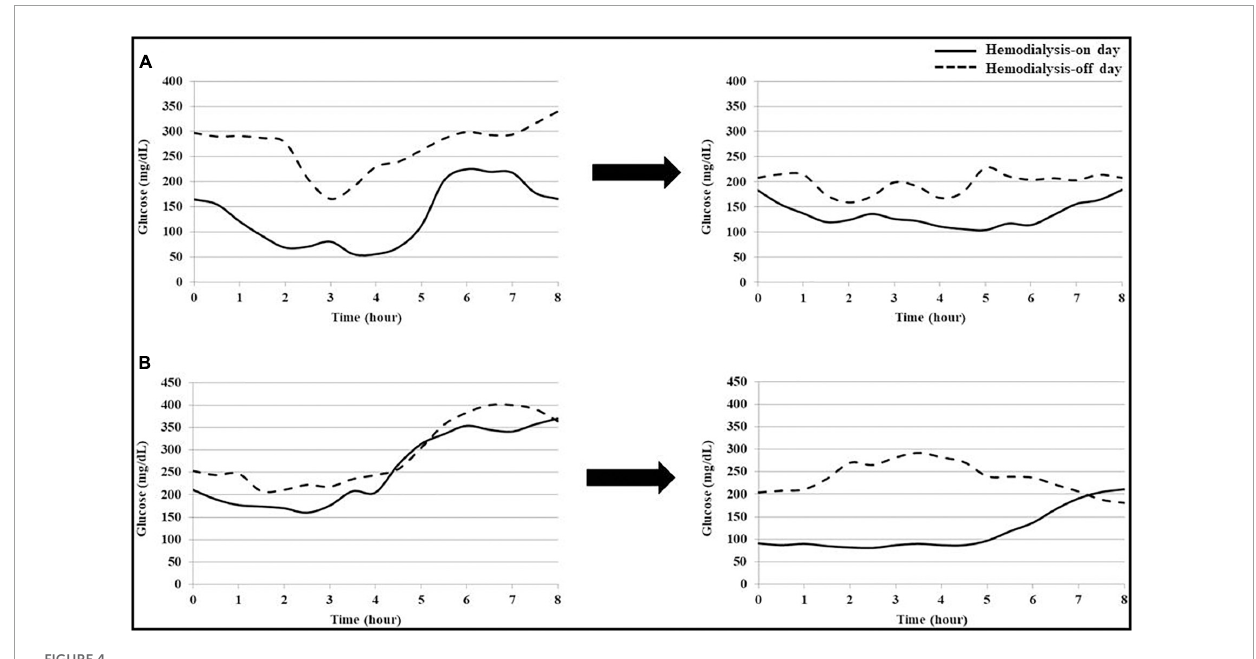
FIGURE4 Changes in blood glucose patterns of each patient with hypoglycemia or hyperglycemia. (A) Patient 1 frequently had hypoglycemia, with blood glucose levels below 70 mg/dL, during dialysis. After treatment intervention using continuous glucose monitoring (CGM), hypoglycemia during dialysis was improved. (B) Patient 2 frequently had hyperglycemia, with a blood glucose level above 250 mg/dL, regardless of dialysis. After treatment intervention using CGM, hyperglycemia was improved on the hemodialysis-on and off